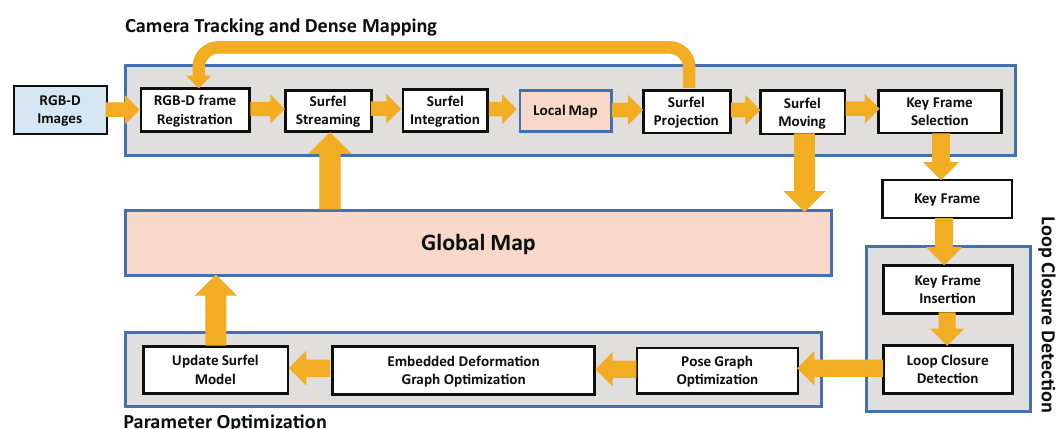
Figure 1. Overview of our dense mapping